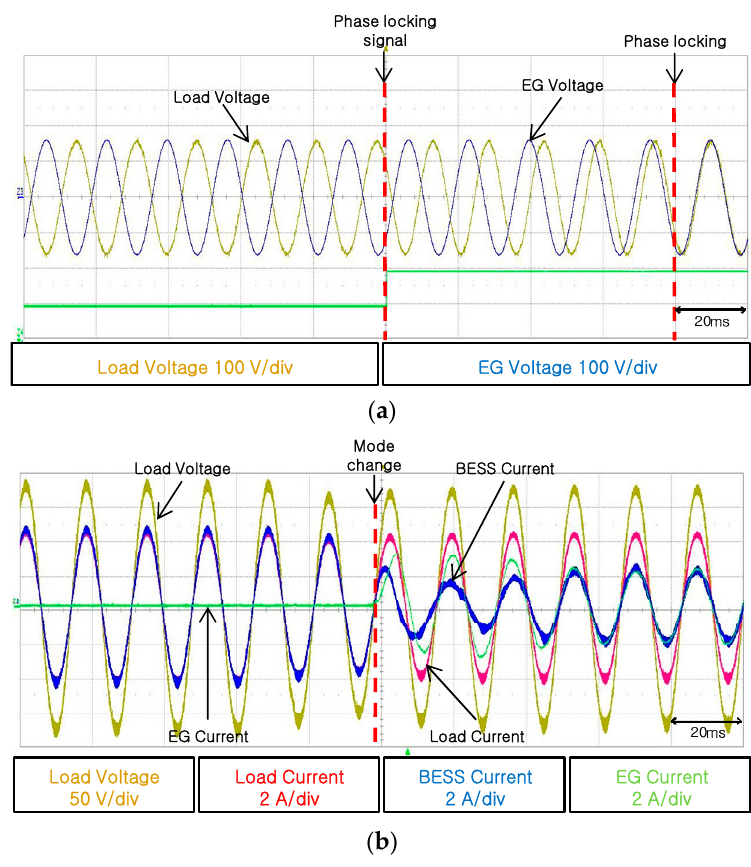
Figure 13. Mode change from voltage control to current control: ( a ) Phase angle tracking; ( b ) Voltage and current variations.